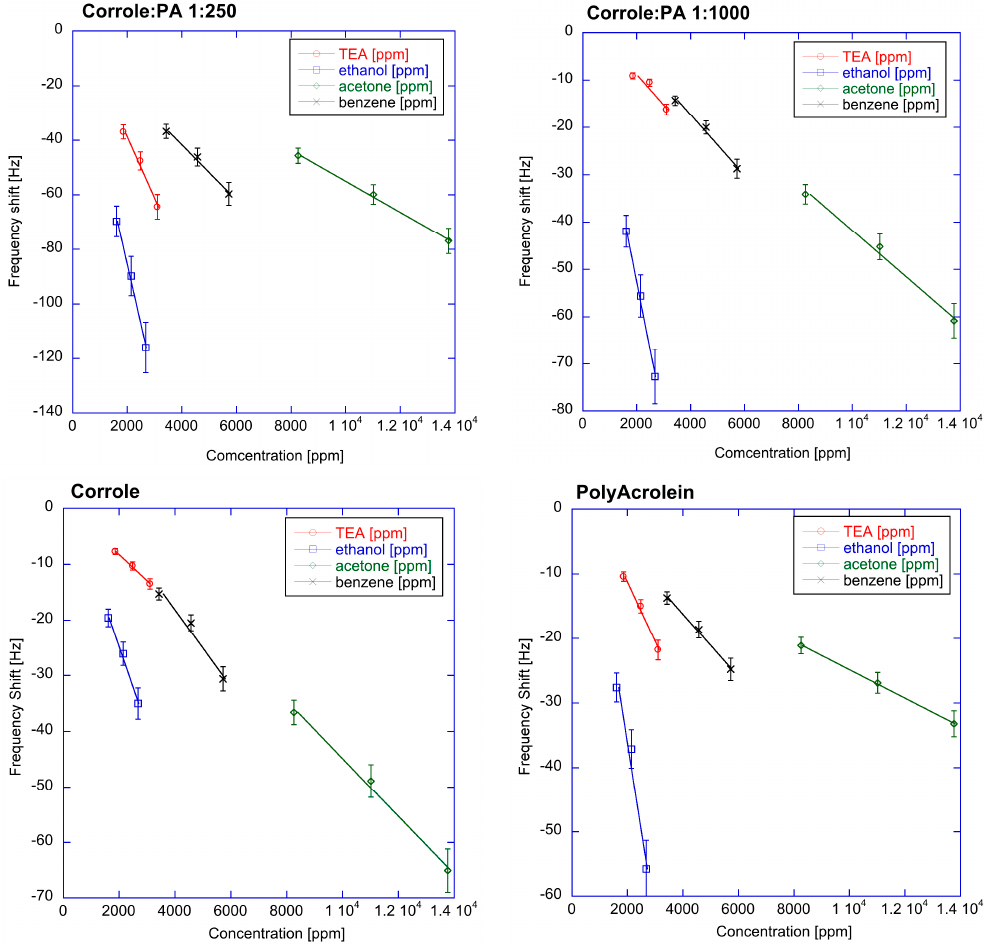
Figure 3. Response curve of four QMBs coated with corrole functionalized polyacrolein at two different acrolein:corrole ratios (1:250 and 1:1000), and two sensors coated with either corrole or